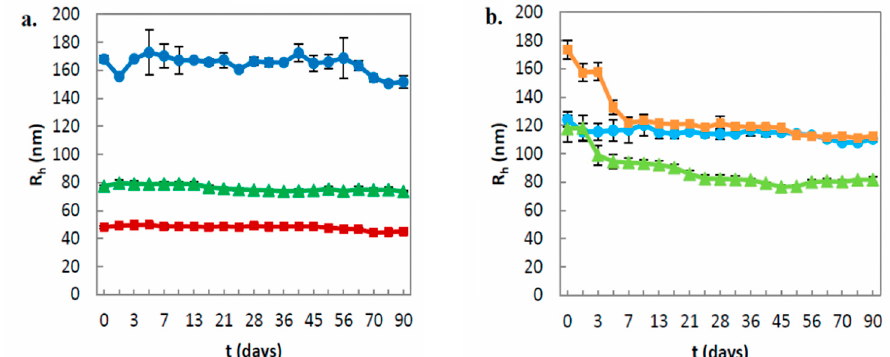
Figure 3. Stability assessment of the size ( R h , nm) of a. GMO nanosystems and b. PHYT nanosystems over time ( (cid:8) : Lipid:PDMAEMA-b-PLMA 9:1, (cid:4) : Lipid:PDMAEMA-b-PLMA 9:3, (cid:78) : Lipid:PDMAEMA-b-PLMA:P407